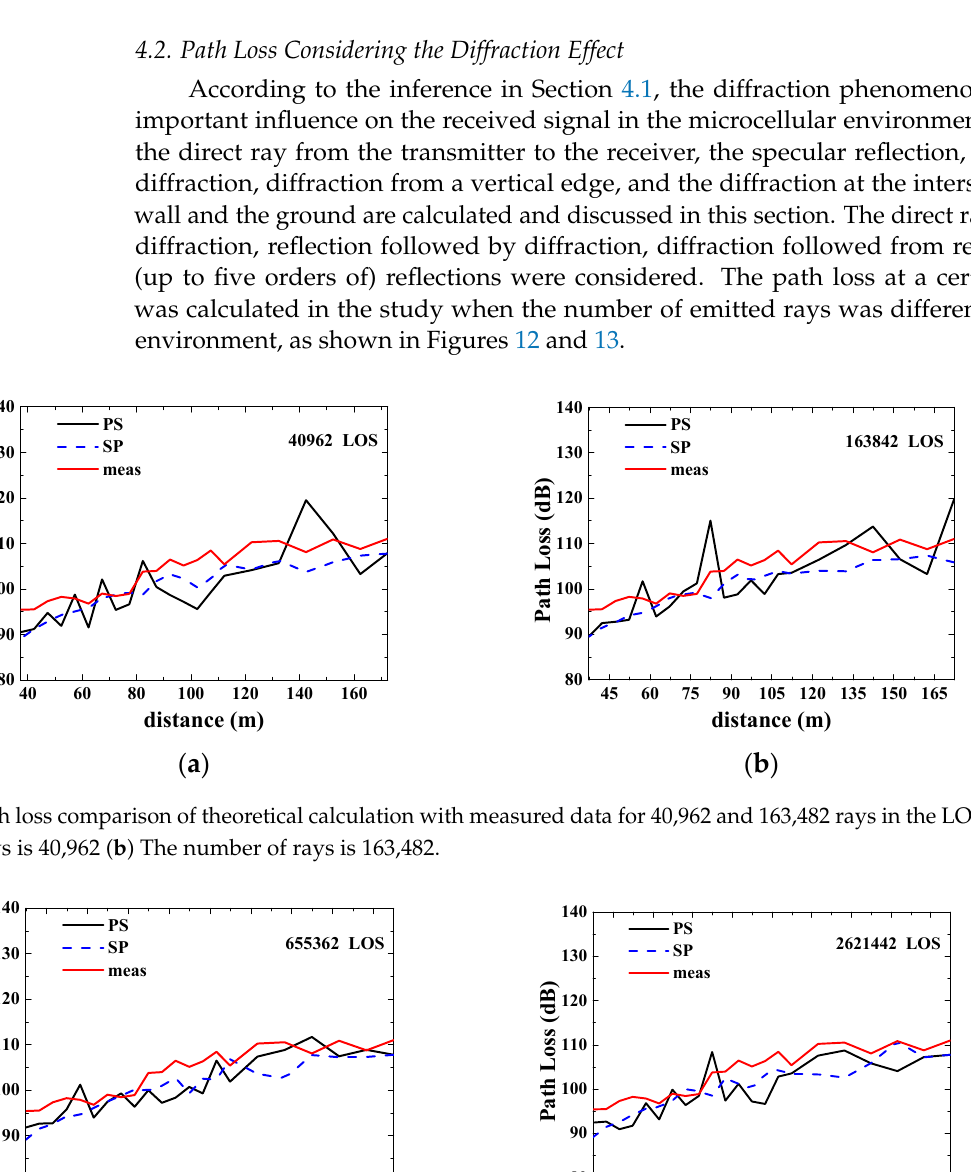
Figure 14. Visualization of the propagation path in a 2D surface at 172.3 m in the LOS. In Figures 15 and 16, the path loss in a certain distance changes with the distance between the transmitting and the receiving antenna in the NLOS environment. It can be observed from these figures that when the distance is between 23 and 55 m, the differ- ence between the theoretical calculation and the measured data is approximately 6 dB for 40,962, 163,842, and 655,362 rays. However, the difference between the theoretical calculation and the measured data is approximately 15 dB when the distance is between 10 and 23 m. This is attributed to the fact that when the diffraction is not considered, there are no multiple reflections from the transmitting to the receiving locations (be- tween 10 and 23 m), and the path loss cannot be calculated. When the diffraction is con- sidered, first-order diffraction, reflection followed by diffraction, and diffraction fol- lowed from reflection would occur from the transmitting to the receiving points. This shows that diffraction has a certain effect in the NLOS case. The difference between the SP method and the measured data may be attributed to the fact that the surrounding fitness equipment and vegetation were ignored. The 3D ray launching method was in